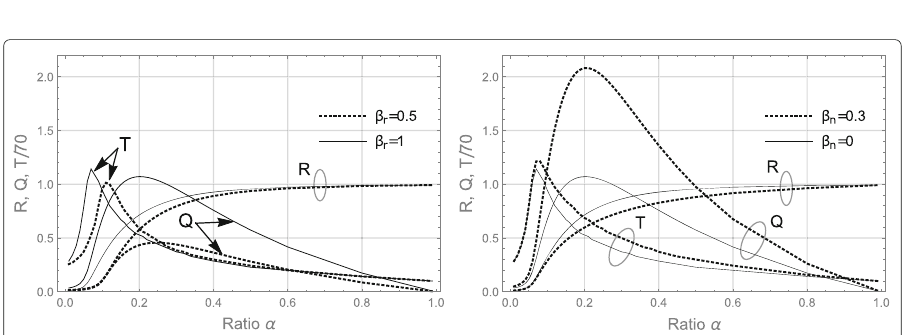
Fig. 5 Left: “ α T ↓ , α Q ↓ , α R ↓ , T (α T ) ↑ , Q (α Q ) ↑ as β r ↑ ” hold. Right: an increase in β n highly enlarges Q (α Q ) . lines correspond to the previous model ( β r = 1, β n = 0), λ s = 0.01, λ n = 0.0015, and N i = 10